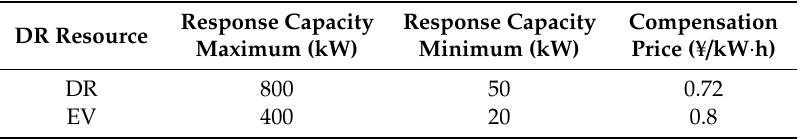
Table 4. Demand response (DR) resource